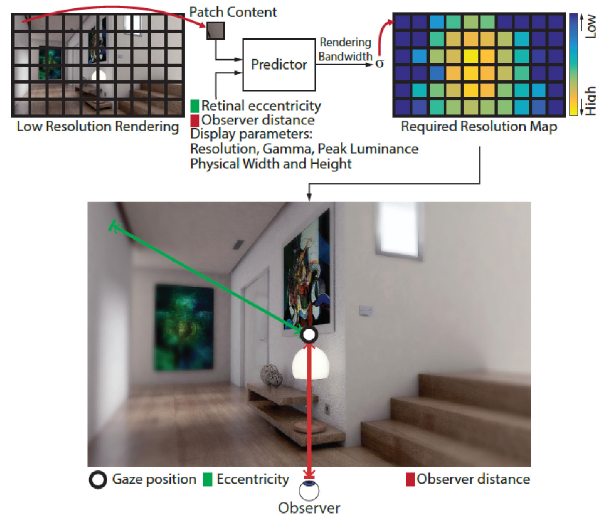
Fig. 14 Luminance-contrast-aware foveated rendering proposed by Tursun et al. [29]. A low-resolution image was first rendered, and then divided into multiple small patches, and subsequently, the standard deviation ρ was calculated to obtain the maximum acceptable resolution reduction for each patch. Finally, the luminance-contrast- aware adaptive resolution rendering was performed through real-time ray tracing. Compared with standard foveated rendering, this method achieved a 0.8–2.6 × acceleration and improved perceptual quality. Reproduced with permission from Ref. [29], c (cid:13) ACM